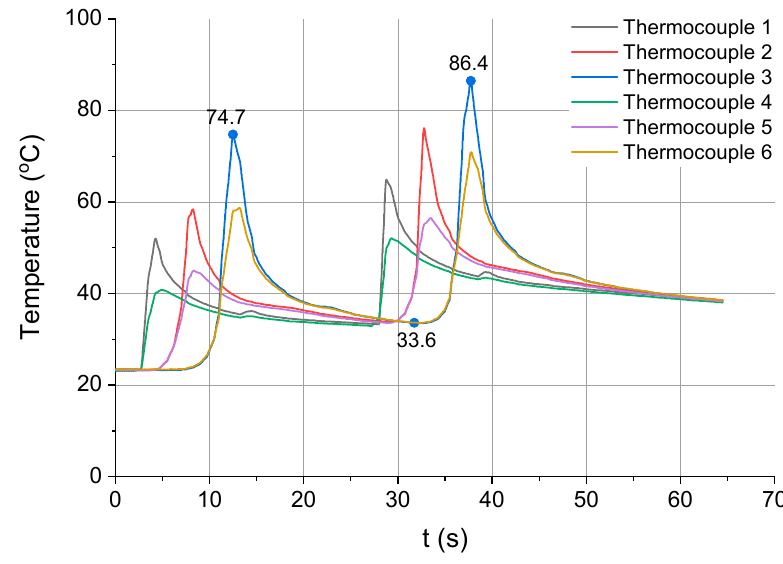
Figure 8. Temperature vs. time for strategy 2 (two passes, a p = 1.5 mm).